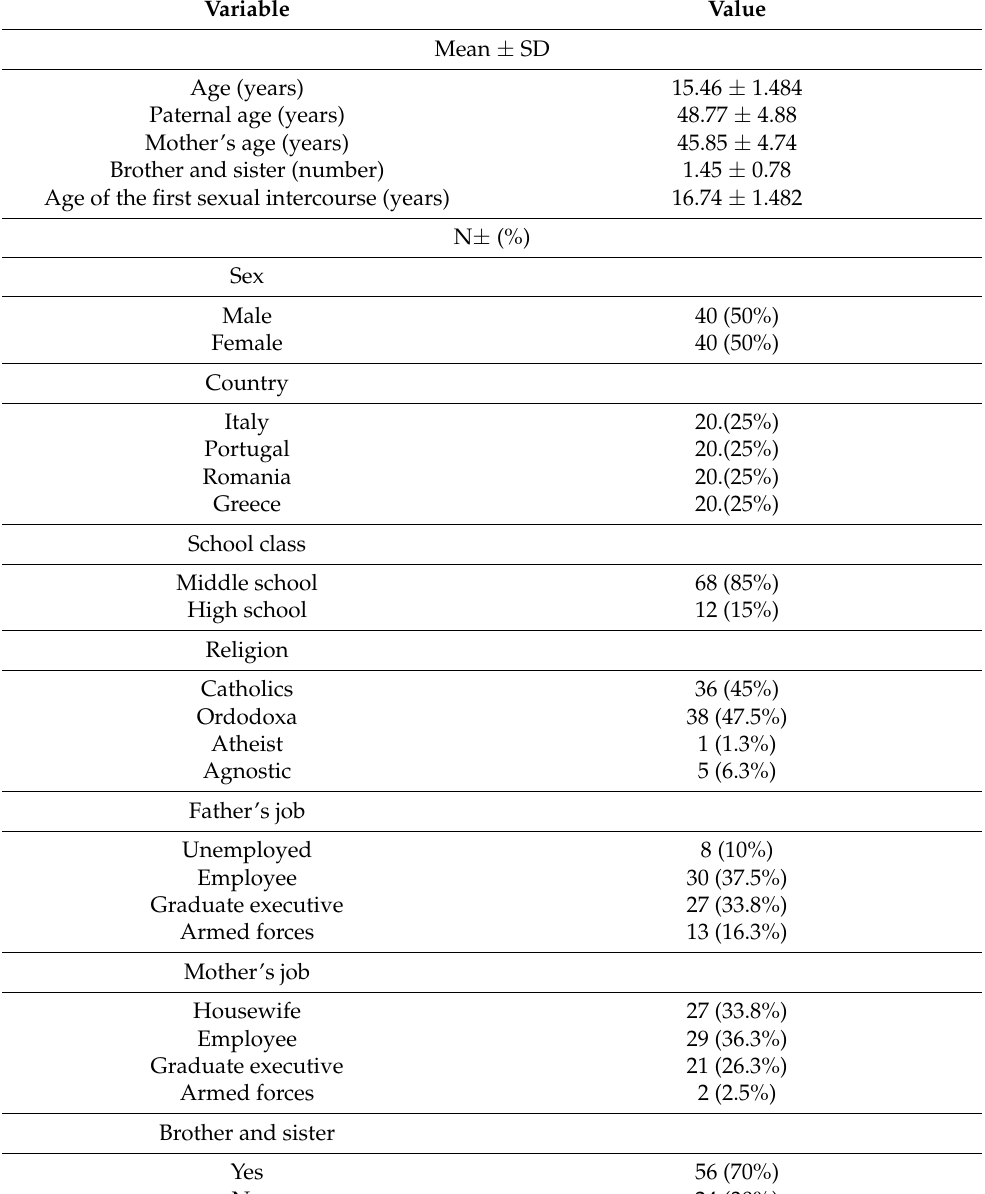
Table 1. Demographics characteristics of the 80